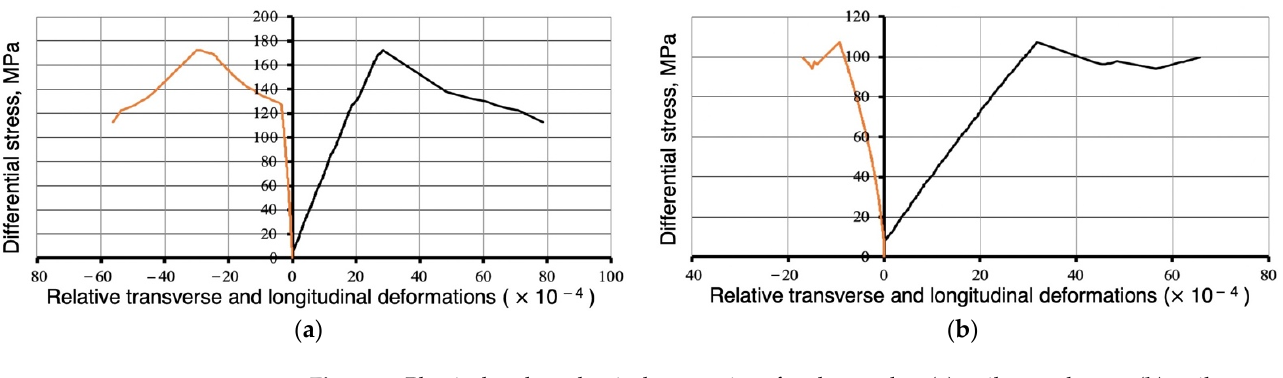
Figure 3. Physical and mechanical properties of rock samples: ( a )—silty sandstone; ( b )—siltstone. Table 1. Strength characteristics of rocks.